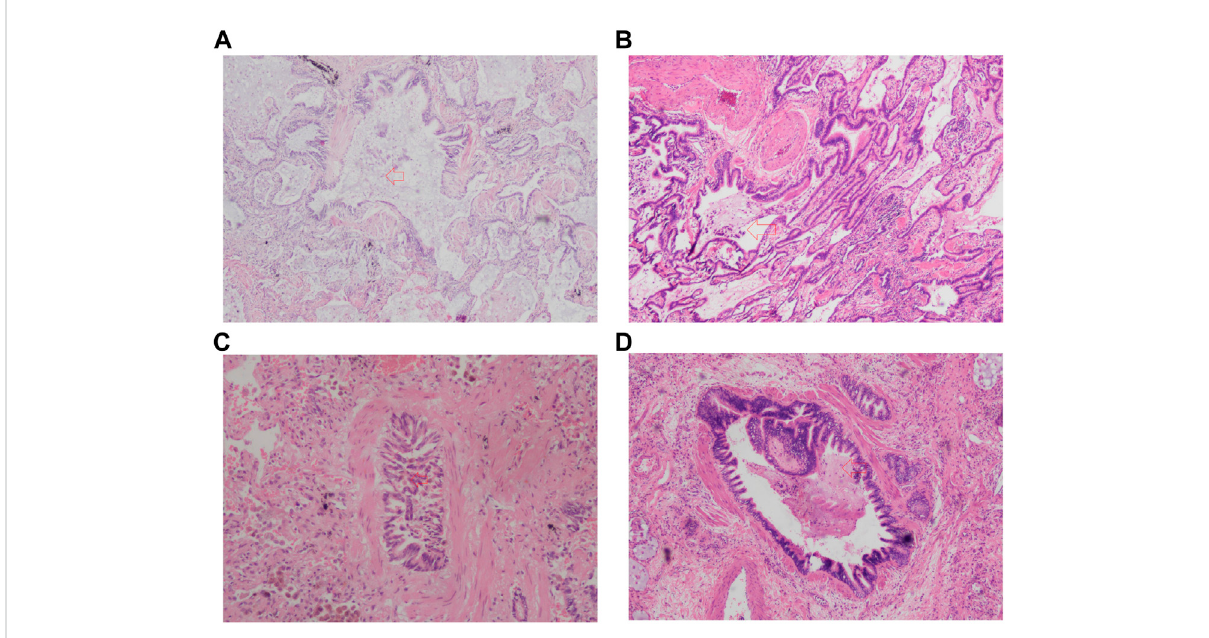
FIGURE 3 ThepathologicimageofSAD. (A) Airwaydistortion; (B) Airwaymetaplasia; (C) Airwayobliteration; (D) Airwayin fl ammationandmucous.Thered arrow points to the